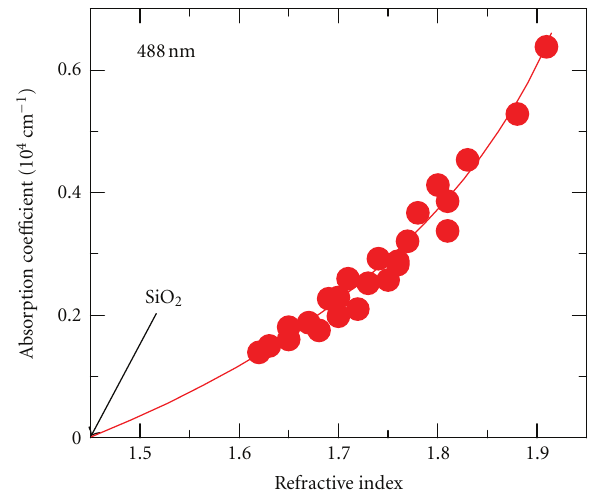
Figure 7: Correlation between the absorption coe ffi cient at 488 nm and refractive index of SiO x films with di ff erent Si excess